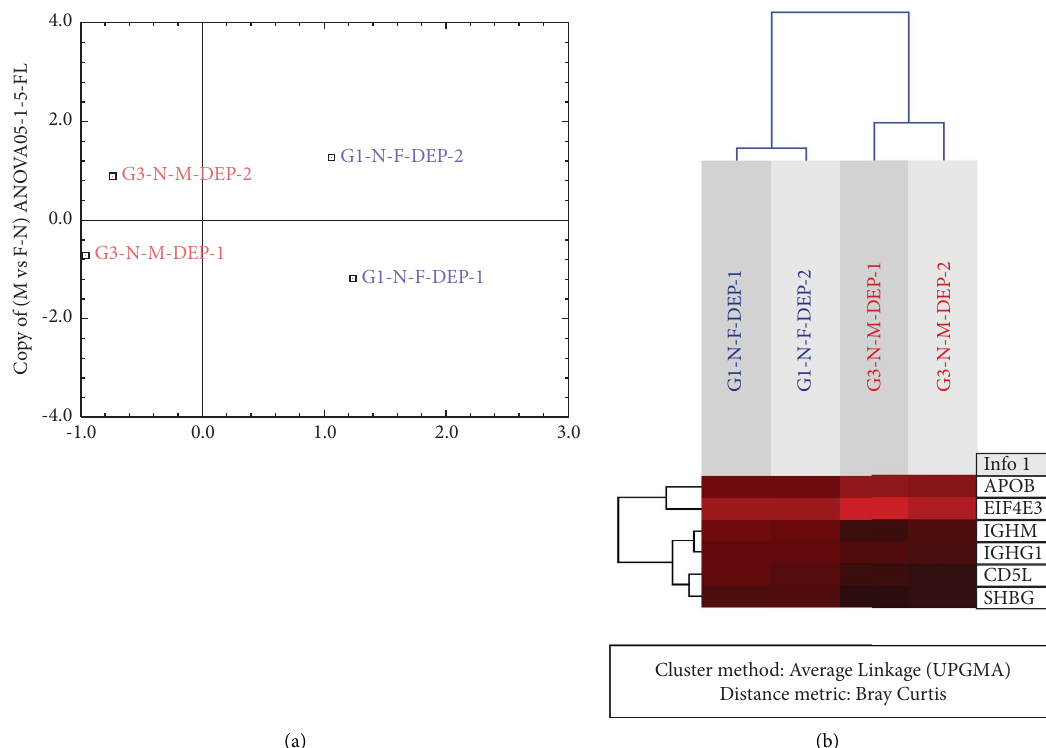
Figure 3: (a) Correspondence analysis (CA) plot of depleted serum samples from healthy subjects using the expression dataset of 5 identifed proteins/peptides (PPs) that were signifcantly diferentially expressed ( P < 0.05-ANOVA, MFC ≥ 1.5- minimum fold change) between men and women. Te expression profles of the identifed PPs clearly diferentiate women from men using correspondence analysis. (Te image was generated using J-express pro V1.1 software program (java.sun.com)). (b) Unsupervised hierarchical cluster analysis of the expression profles of depleted serum samples using 5 proteins that difer signifcantly ( P < 0.05, analysis of variance; maximum fold change ≥ 1.5) between men (red) and women (blue). Te dendrogram was generated using the Bray–Curtis correlation distance metric and an average linkage clustering method from the J-express pro V1.1 software program (java.sun.com). Note . One PP (IGHG1) was upregulated in both nondepleted (Figure 2) and depleted